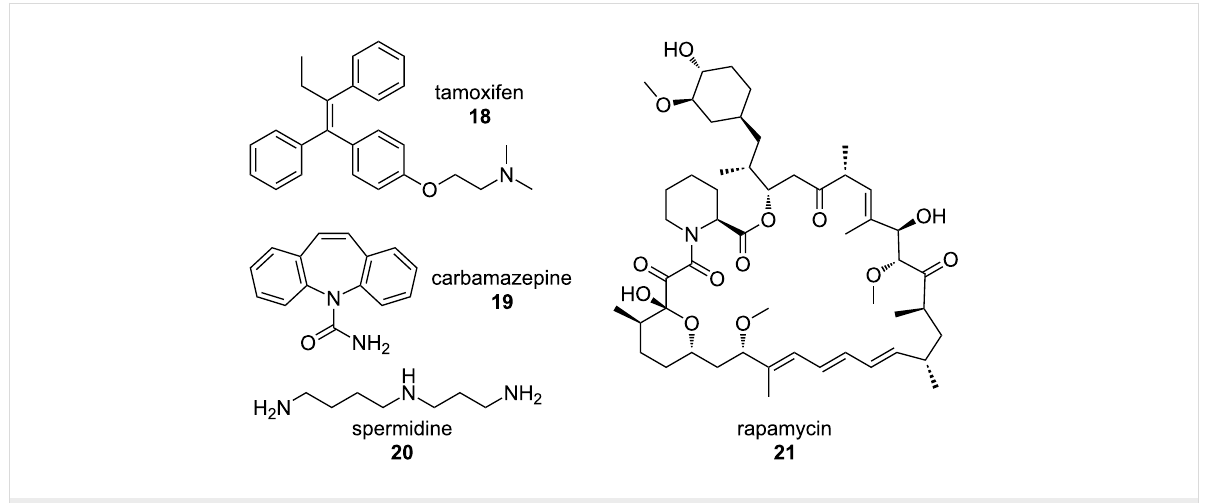
Figure 10: Pharmacological inducers of autophagy.